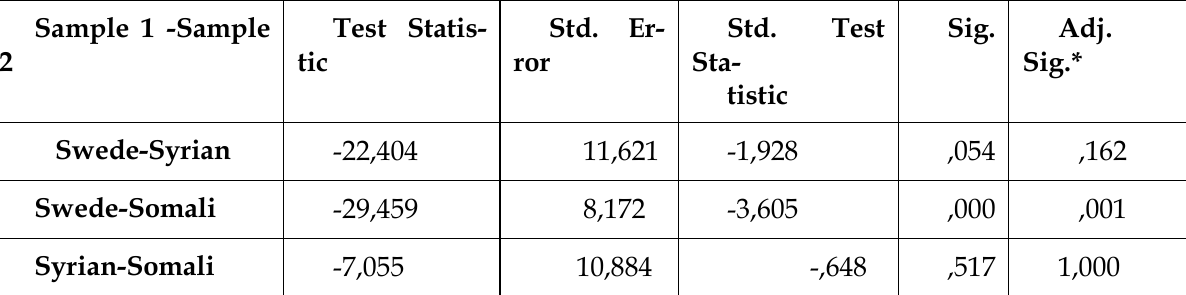
Table 28. Willingness to use the Digital Health Centre and age. Pairwise comparison (Bonferroni). Each row tests the null hypothesis that the Sample 1 and Sample 2 distributions are the same. Asymptotic significances (2-sided tests) are displayed. *Significance values have been adjusted by the Bonferroni correction for multiple tests.